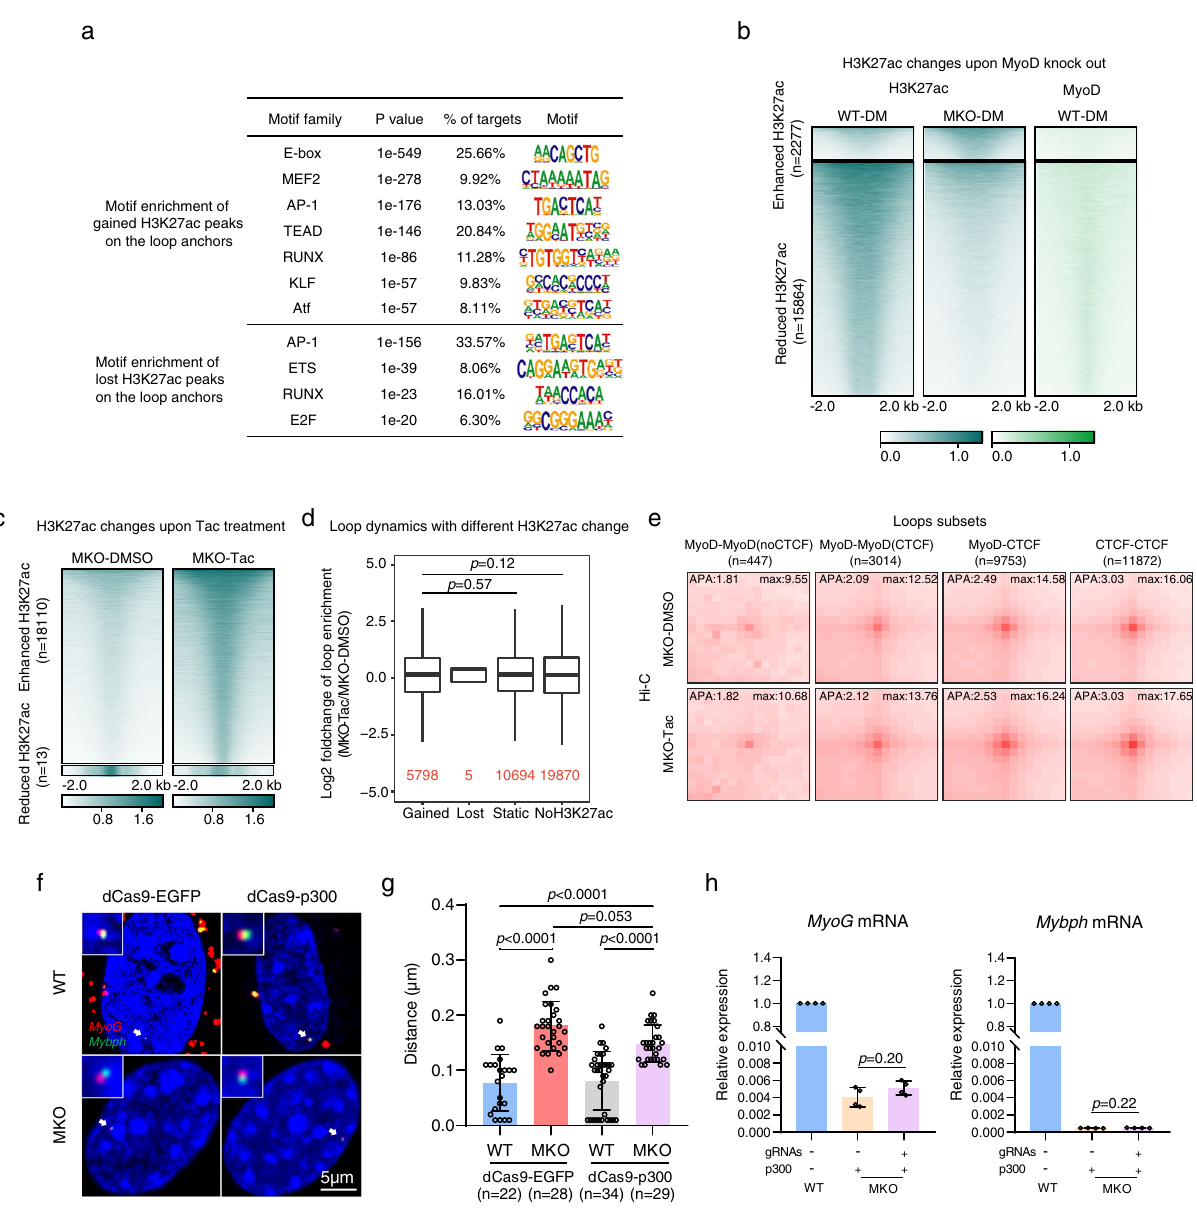
Fig. 7 H3K27ac enhancement in MKO cells is not suf fi cient to drive the formation of MyoD-bound chromatin loops. a Motif enrichment at loop-anchor H3K27ac peaks gained or lost in WT-DM cells compared with WT-GM cells. p -values of motif enrichment were determined using cumulative binomial distributions, as applied by Homer. b Heatmaps showing H3K27ac peaks found to be enhanced and reduced on ChIP-seq analysis of MKO-DM cells versus WT-DM cells. MyoD-binding peaks at those differential H3K27ac peaks are also shown. c Heatmaps showing H3K27ac peaks enhanced and reduced on ChIP-seq analysis of MKO cells treated with the selective class I HDAC inhibitor, Tacedinaline (Tac), in DM for 12 h. DMSO-treated MKO cells served as a control. d Loop-strength fold changes of the loops with gained, lost, static or no H3K27ac marks on their anchors between MKO cells treated with Tac or DMSO. Loop strength was de fi ned as relative Hi-C contacts found at loop pixels compared with those at surrounding donut-shaped background pixels (see Methods). The loop numbers are marked in red. p -values were calculated by the one-sided Wilcoxon rank-sum test. Source data are provided as a Source Data fi le. e APA plots showing aggregated Hi-C contacts around the four types of chromatin loops (classi fi ed in 2 d ) in MKO cells treated with Tac or DMSO (control). f Representative dCas9-mediated DNA images visualizing the chromatin loops linking MyoG (red) and Mybph (green) in WT and MKO cells transfected with dCas9-p300core and cultured in DM for 24 h. dCas9-EGFP served as a control. g The distance between the two anchors visualized in f . The scale bar represents 5 μ m. Data are presented as mean ± SEM. p -values were determined by ANOVA followed by Tukey ’ s multiple comparison test, *** p < 0.001. Source data are provided as a Source Data fi le. h Relative expression of MyoG and Mybph in the cells described in f , as determined by qRT- PCR. Data are presented as mean ± SEM. p -values were determined by ANOVA followed by Tukey ’ s multiple comparison test. n = 3 biologically independent samples. Source data are provided as a Source Data fi